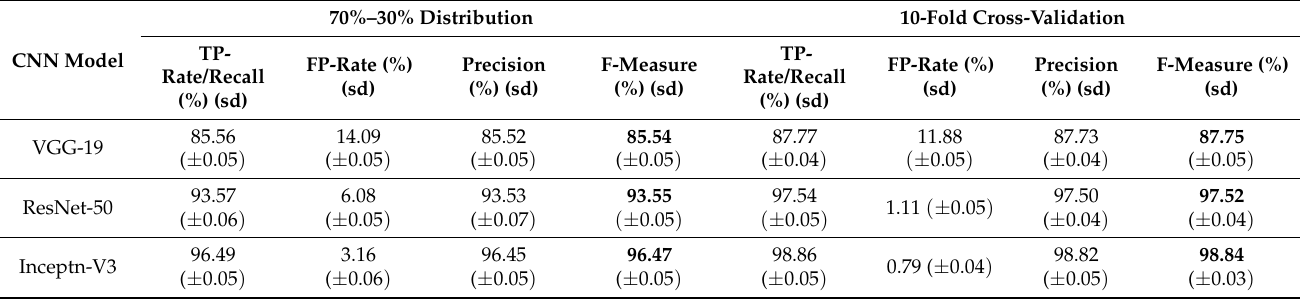
Table 6. Performance of CNN models with respect to diverse metrics using dataset 2.